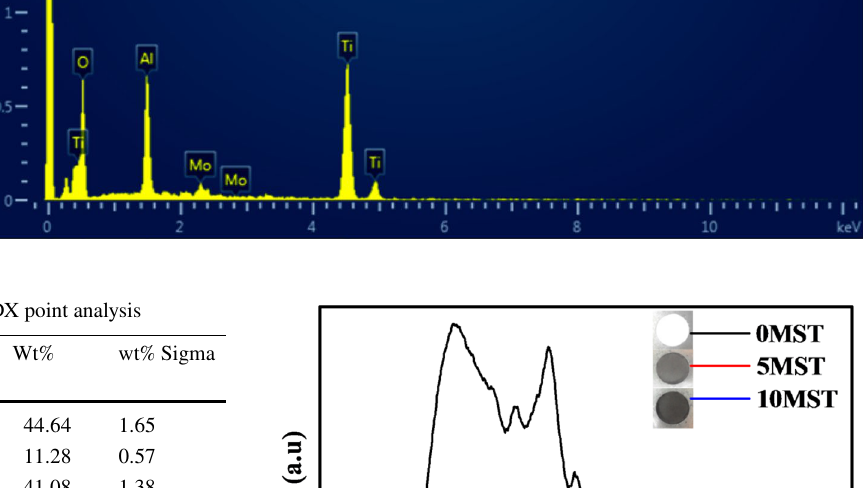
Fig. 4 Energy-dispersive X-ray spectroscopy mapping of 5 MST sample, confirming the presence of Ti, O, Mo and Al